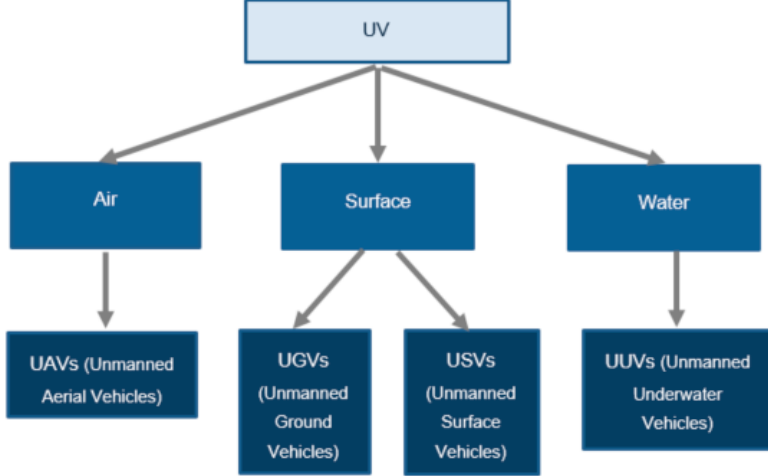
Figure 1. Unmanned vehicle (UV) classification by field of performance.